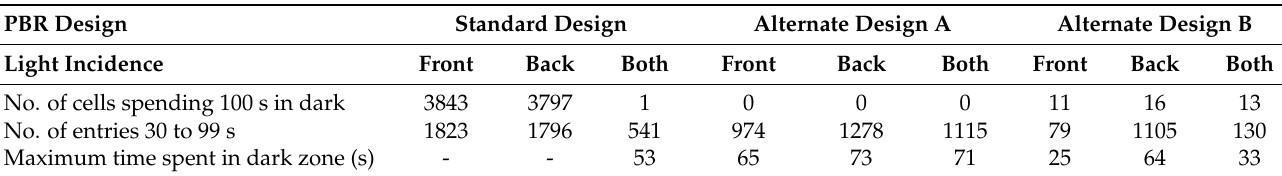
Table 2. Characteristics of durations continuously spent in dark zones for different designs and light incidence from different sides. Simulations were performed with an air flowrate of 0.5 L/min, concentration of 0.5 kg/m 3 , and total incident intensity of 1000 µ E/m 2